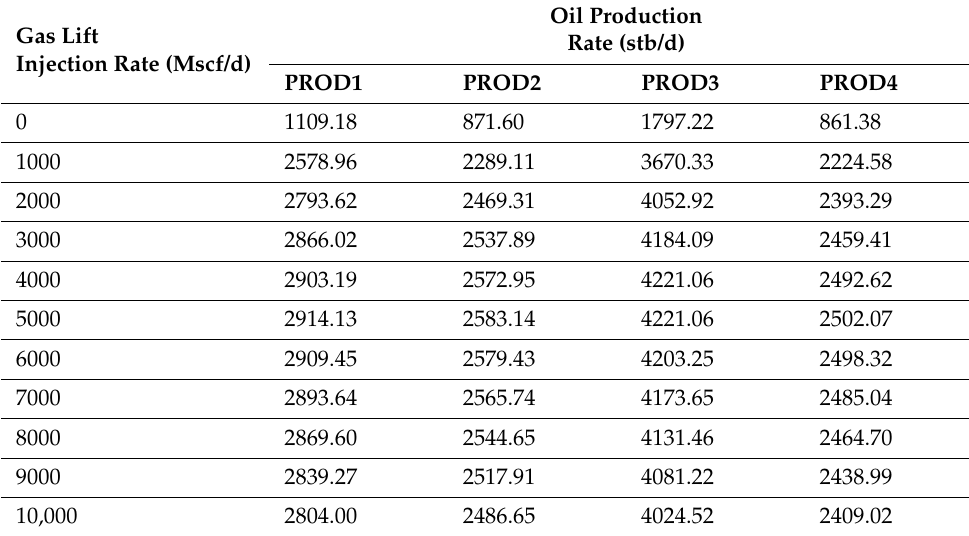
Table 2. Gas lift injection rate with oil production rate for each well [30].